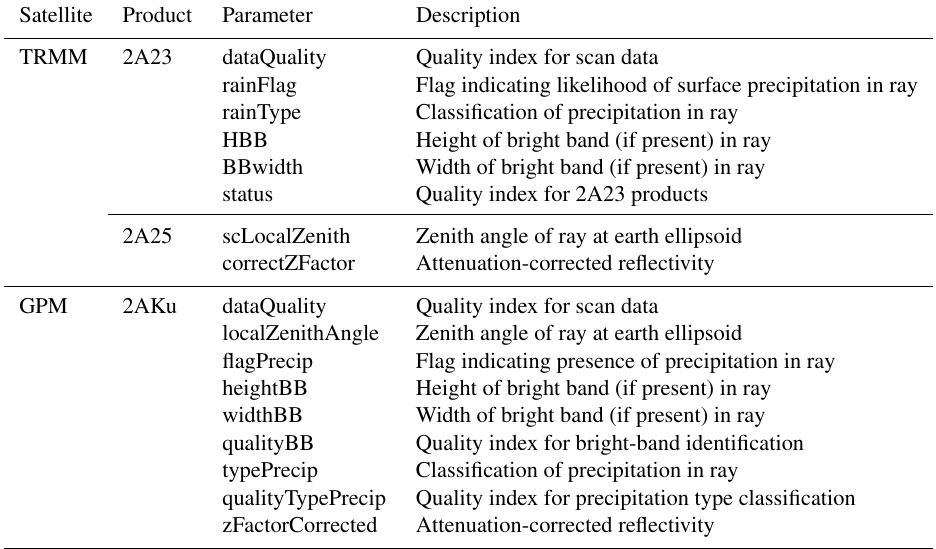
Table 2. TRMM and GPM parameters used for analysis, based on Table 3 of Warren et al.